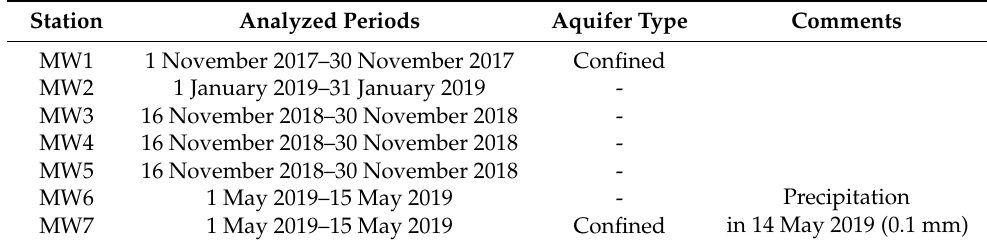
Table 2. Results of aquifer type tests using harmonic